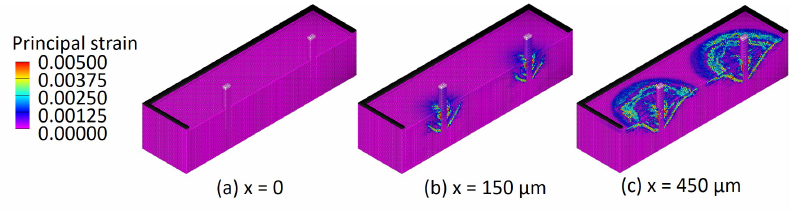
Figure 19. Analysis model with different spacing.